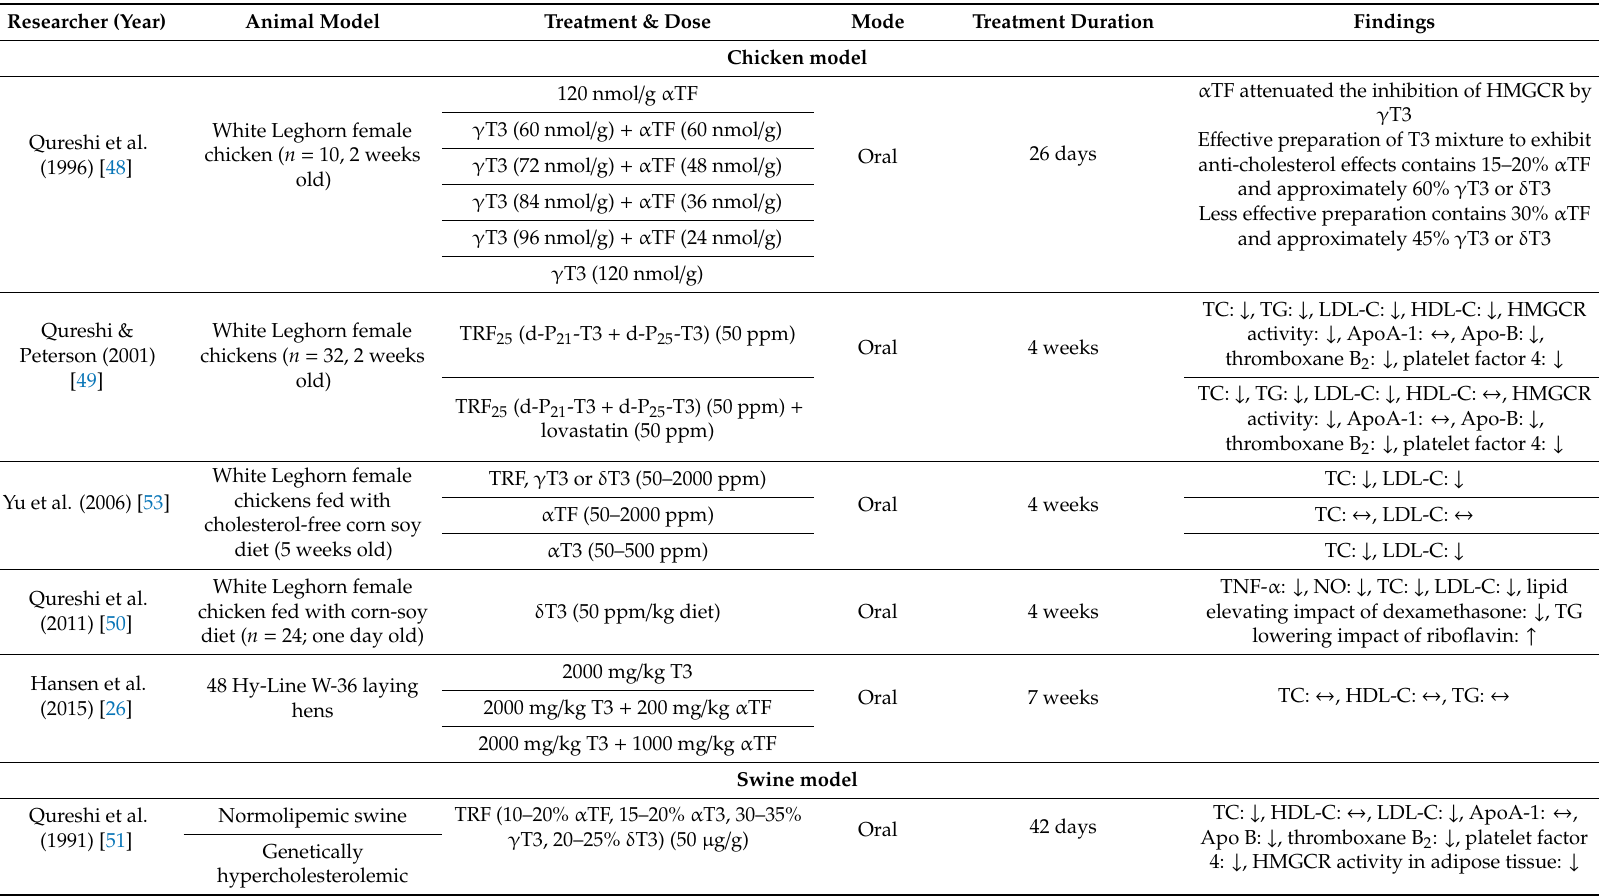
Table 2. E ff ects of T3 on lipid metabolism in